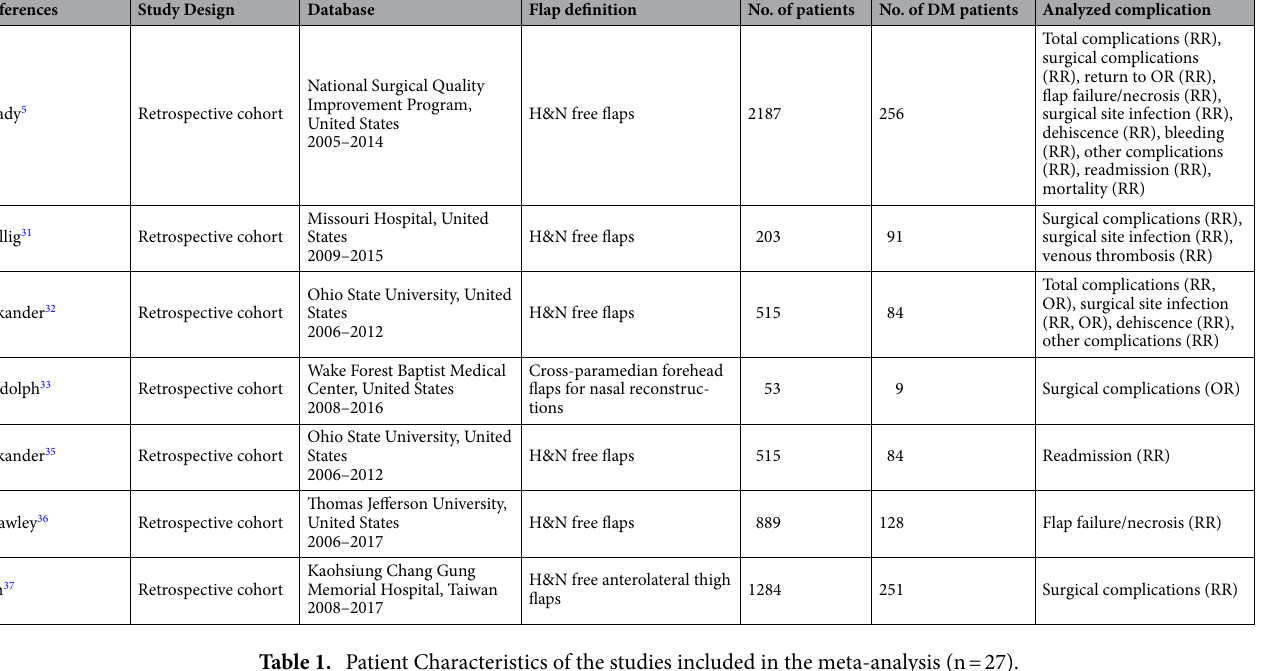
Table 1. Patient Characteristics of the studies included in the meta-analysis (n = 27).